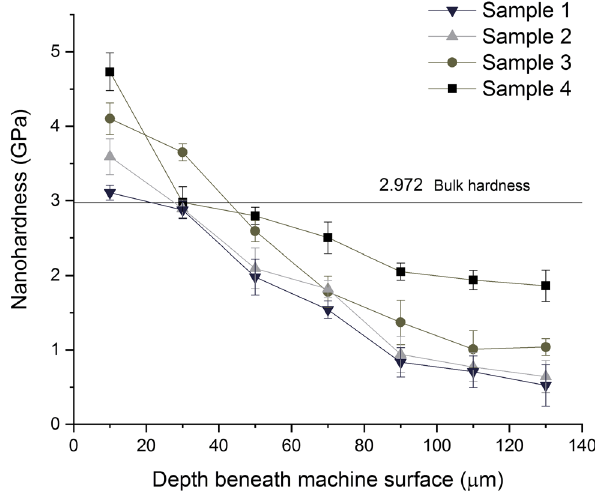
Figure 9: The nano - hardness value measured on the sub - surface of the machined surface under various cutting